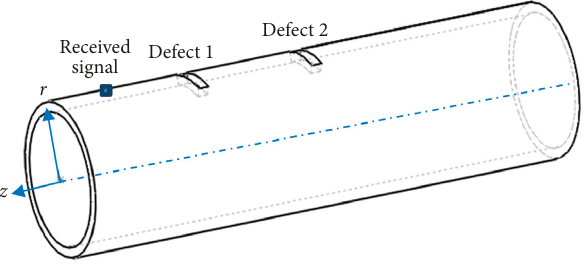
Figure 11: Double-defect pipe models of different signal is recorded as t 2 . The damage axial position x can be calculated by equation (4). The schematic diagram of the calculation of the axial position of the damage is shown in Figure 18.